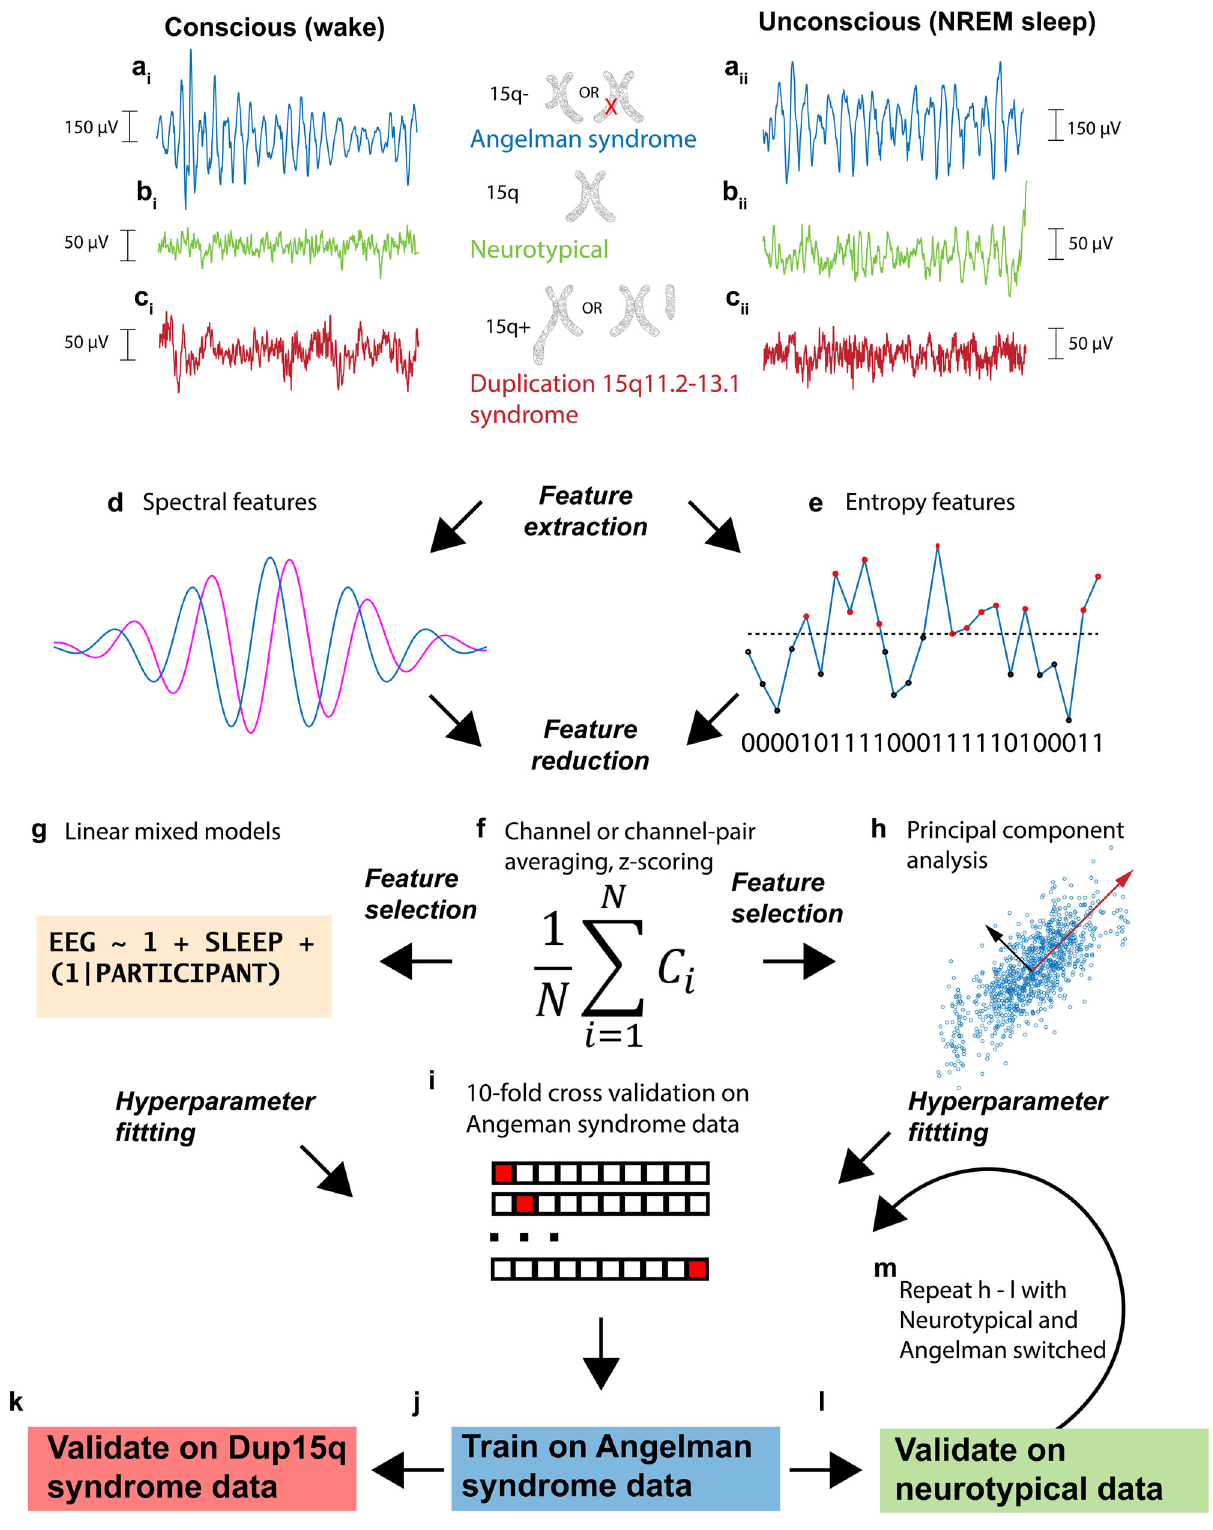
Table 4). To test the robustness of k in the k-fold cross-validation used to fi t the regularization parameter and to report cross- validation performance in AS, we also performed the analysis with 5-fold cross-validation and observed highly similar results (Supplementary Table 5). A supplementary analysis also directly compared entropy and spectral EEG features after performing